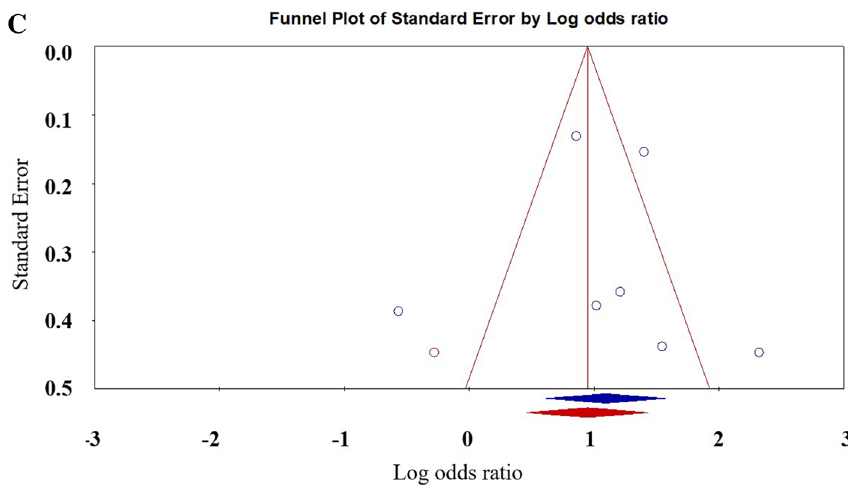
Figure 7. Filled funnel plot of the relationship between non-suicidal self-injury and